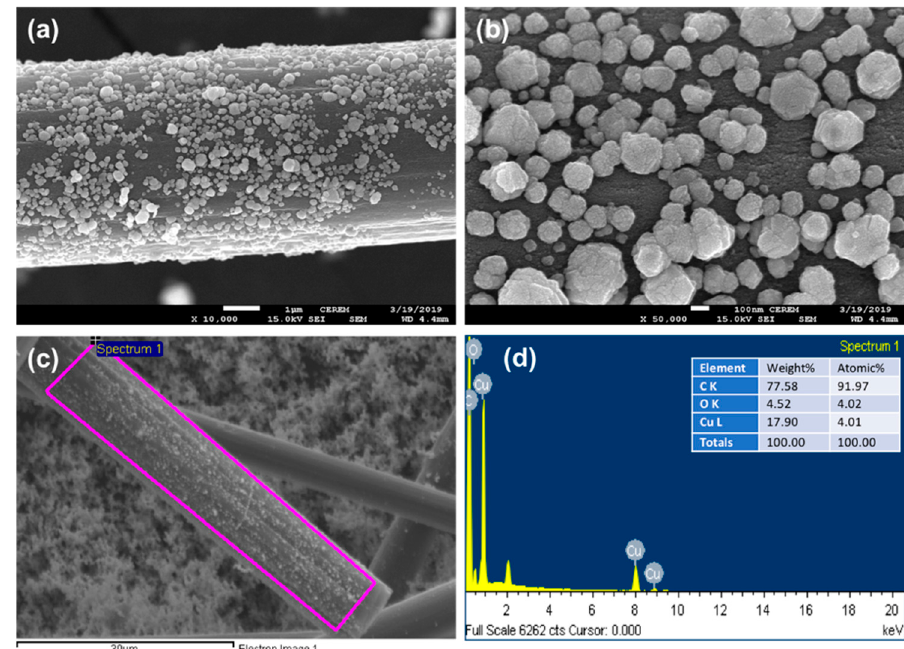
Figure 8. Carbon fibers metallized using the electroless copper deposition method: ( a ) SEM image at low resolution; ( b ) SEM image at high resolution; ( c ) Selected area for EDAX analysis; and ( d ) EDAX elemental analysis.